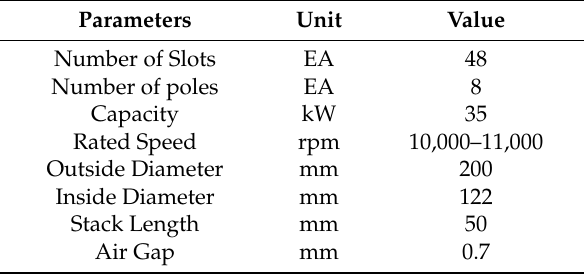
Figure 1. Slot stator and 8-pole rotor core: ( a ) stator core; ( b ) rotor core. Table 1. Interior permanent magnet synchronous motor (IPMSM) basic specifications.